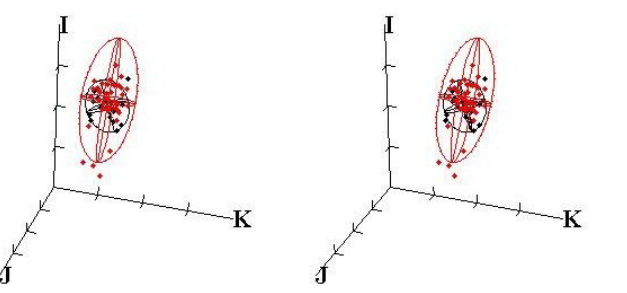
Figure 5 . Stereo-pair scatter plot (with included 95% distribution ellipsoids) of P1 (black data points) and P2 (red data points) devoid of possible outliers. The origin of the scatter plot is 41.85 I D.